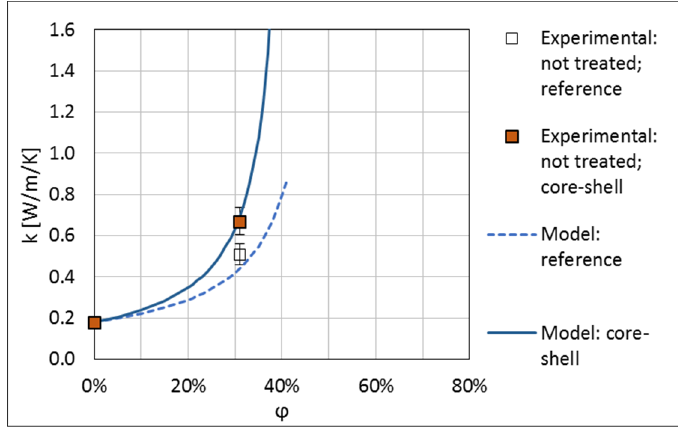
Figure 9. Thermal conductivity of composites with untreated fillers. The lines show the results of model calculations.